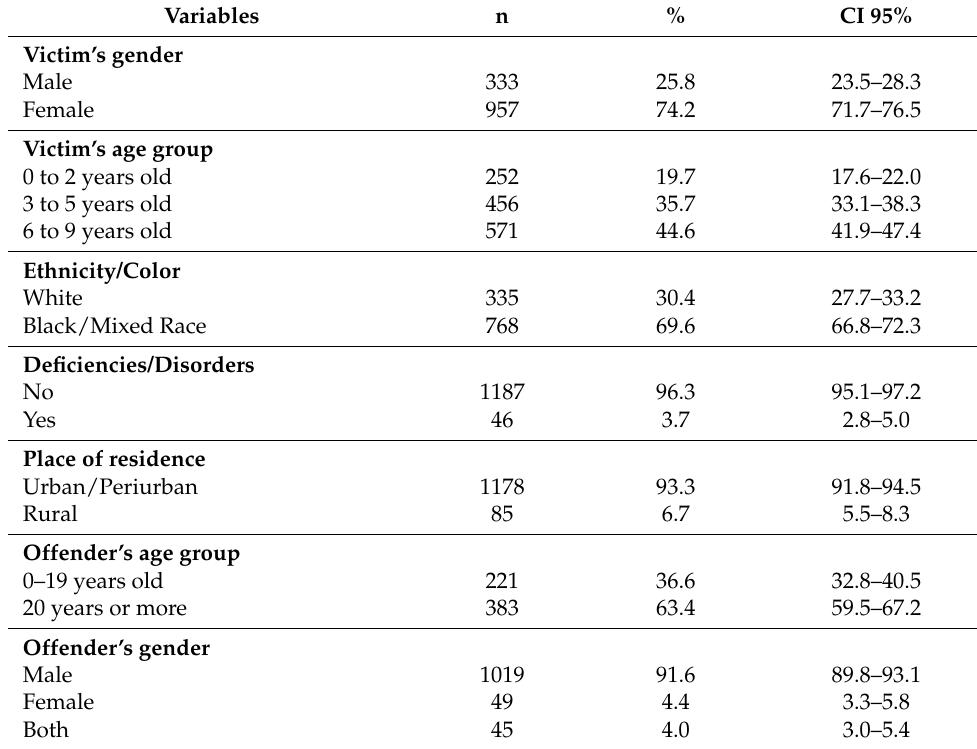
Table 1. Characterization of reported cases of sexual violence against child according to data from the victim, the offender and the offense. Esp í rito Santo, 2011 to